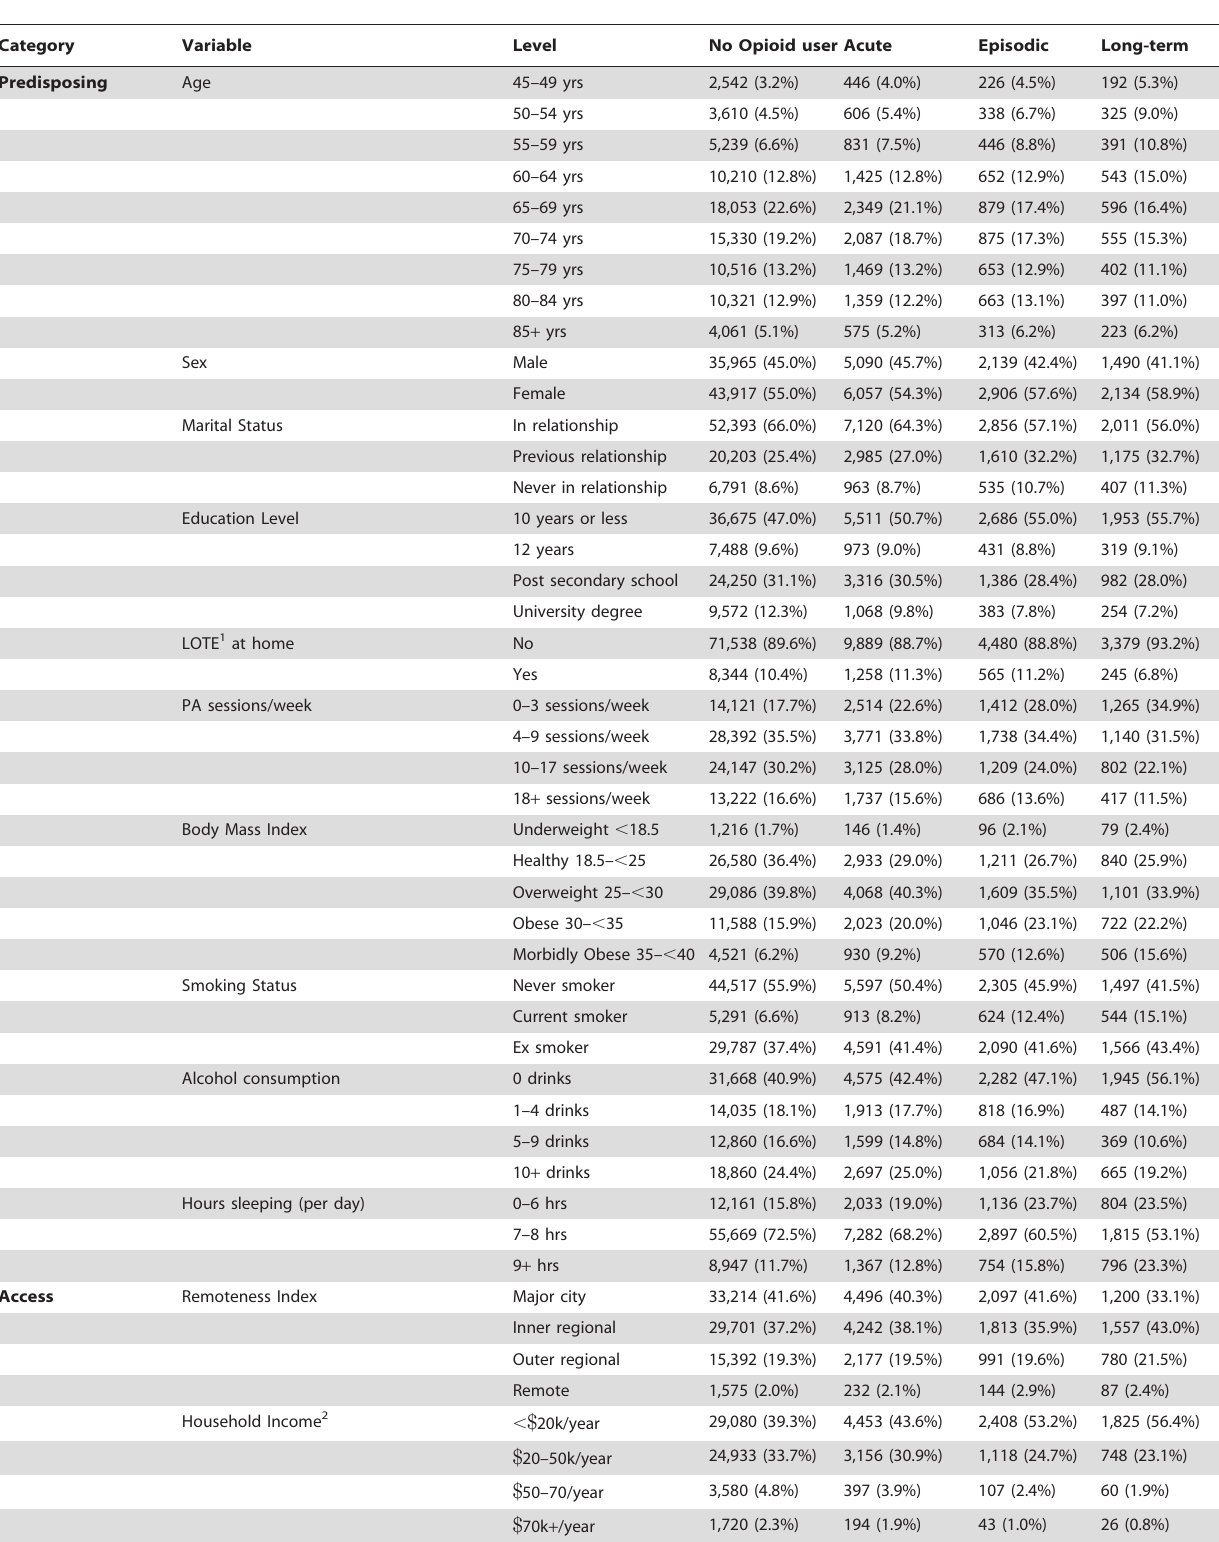
Table 1. Personal characteristics of individuals (n, (% of treatment group)) dispensed opioid analgesics, by treatment group (Acute – supply , 90 days; Episodic – Supply $ 90 days, , 3 increased quantity dispensings; Long-term – Supply $ 90 days, $ 3 increased quantitative